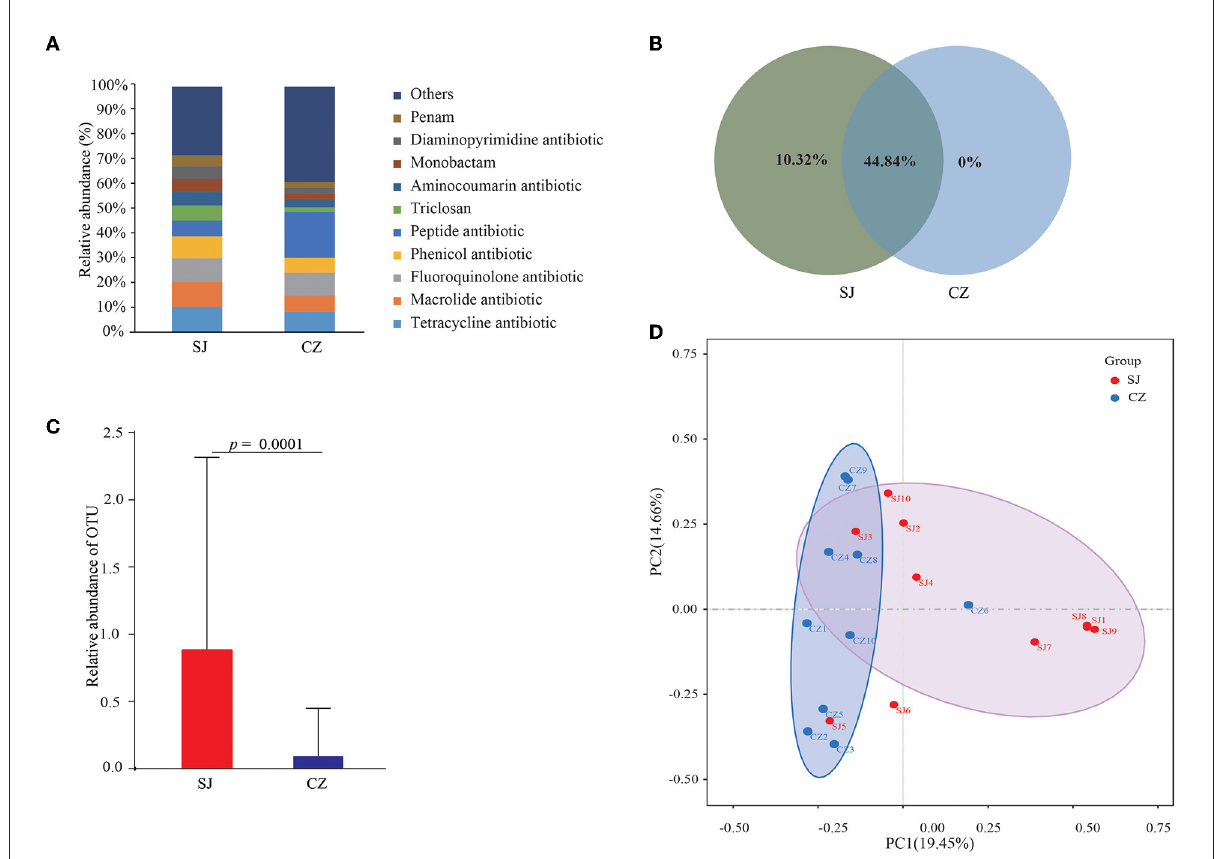
FIGURE4 Fractions of relative abundance of genes (A) , Venn analysis (B) , difference in the relative abundance of operational taxonomic units (OTUs) (C) , and principal component analysis (PCA) (D) of Anser erythropus sampled from Shengjin (SJ) and Caizi (CZ)